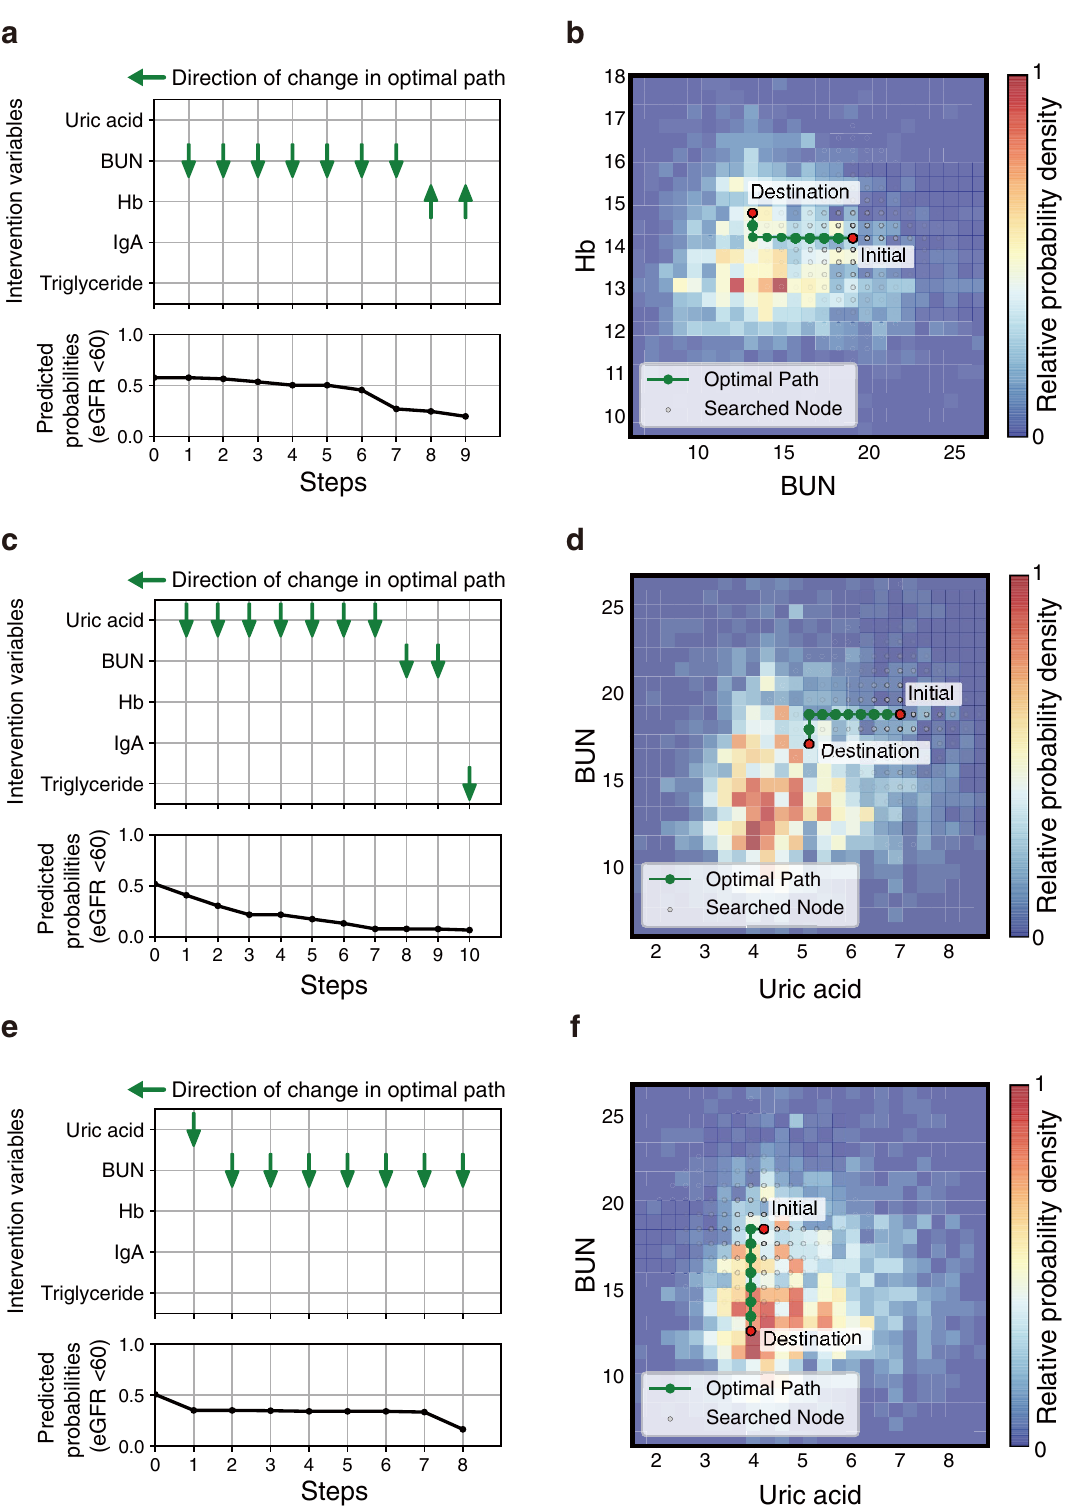
selected from a framework-proposed path and nine random paths by the nephrologists. Based on the guideline 46 , the direction of improvement when generating random paths was set as follows: increase for Hb and decrease for triglyceride, RADIA, and weight. The framework-proposed paths exhibited a signi fi cant decrease in predictive CKD risk compared to the paths selected by the